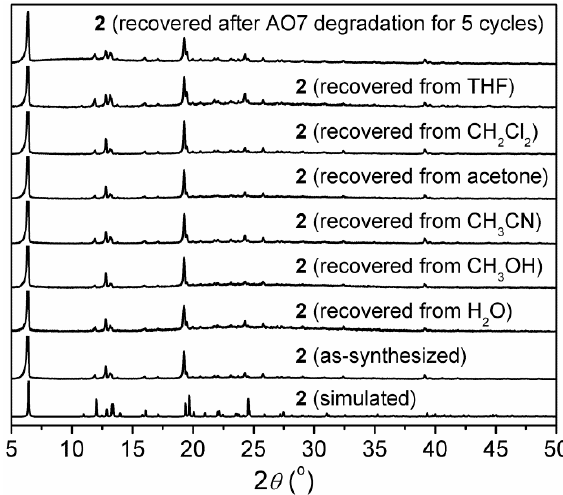
Figure 4. X-ray powder diffraction (XRPD) patterns of 2 : simulated, as-synthesized, after immersing in various solvents (H 2 O, CH 3 OH, CH 3 CN, acetone, CH 2 Cl 2 and THF) for 1 day and after AO7 degradation experiments by H 2 O 2 for 5 cycles under daylight.